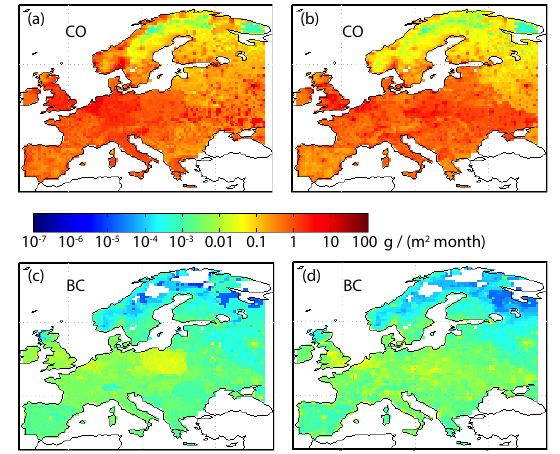
Figure A5. Comparison of annual anthropogenic CO and BC emis- sions for 2090: (a, c) 50% of ECLIPSE GAINS 4a MFR for 2050 as assumed for 2090 in present study and (b, d) PEGASOS PBL v2